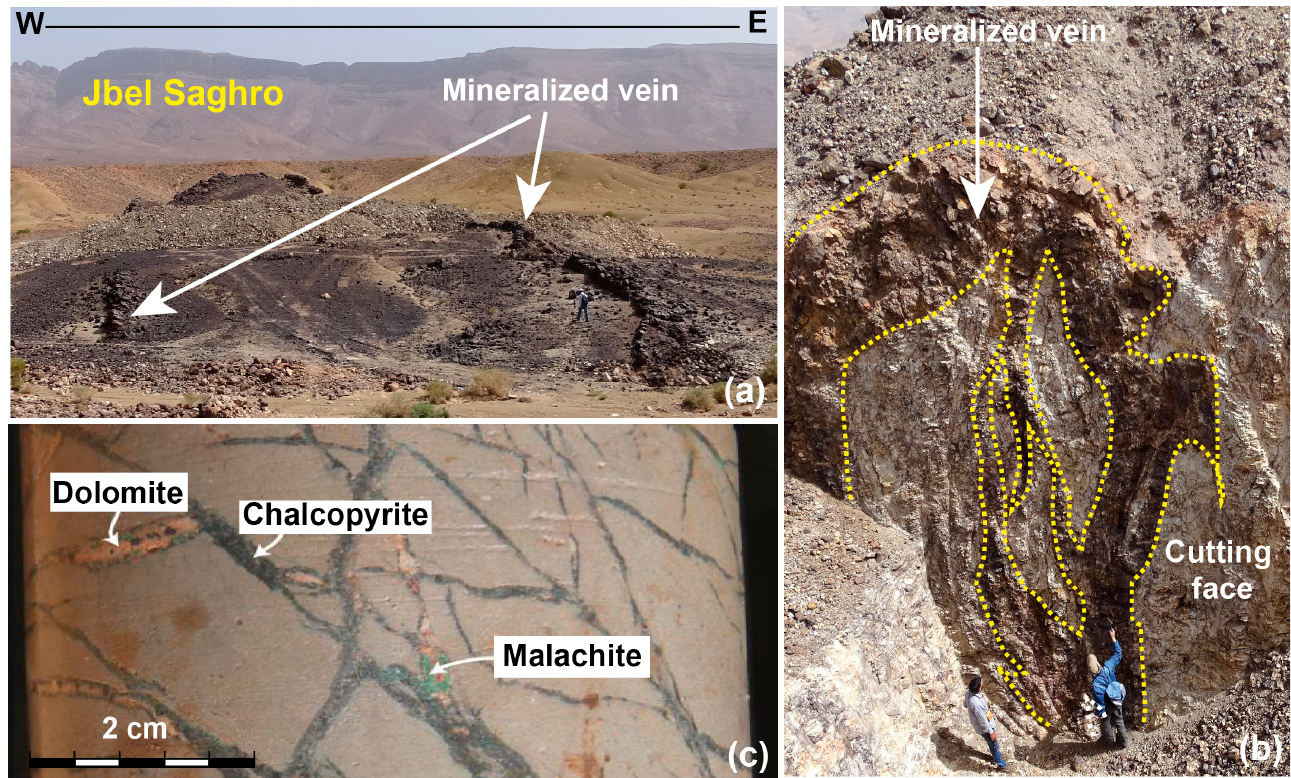
Figure 10. ( a ) Mineralized veins of Timarighine, south of Saghro (N 30°52 ′ 39, 33 ″ ; W 5°36 ′ 49, 83 ″ ). ( b ) Sectional view illustrating the morphological variations (thickening, thinning, branching) of the veins. ( c ) Chalcocite, malachite, and dolomite stockwork (core sample from Jbel Laassel, Bourque [21]).